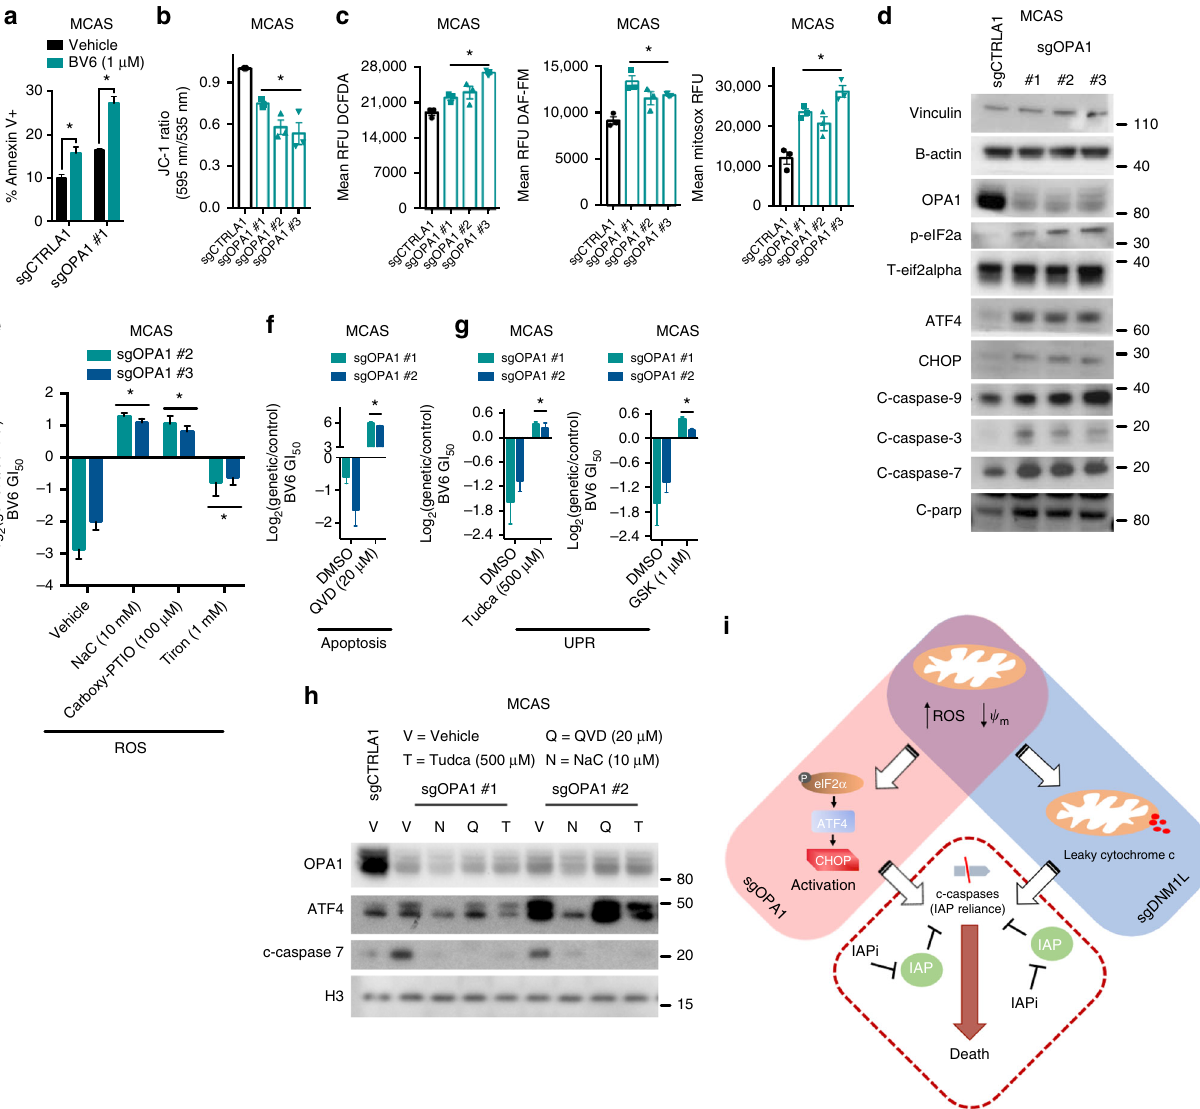
Fig. 5 OPA1 loss leads to induction of ER stress markers and changes in the levels of cleaved caspases. a Percentage of annexin V + MCAS cells transduced with a control targeting sgRNA or a sgRNAs targeting OPA1 ( n = 3). Data are mean ± SEM. * p < 0.05 by Student ’ s t -test. b Ratio of JC-1 fl uorescence (595 nm/535 nm) in MCAS cells transduced with control sgRNA or three independent sgRNAs for OPA1 ( n = 3). Data are mean ± SEM. * p < 0.05 by one-way ANOVA. c Left, DCFDA raw fl uorescence units minus no stain fl uorescence units in MCAS cells transduced with control sgRNA or three independent sgRNAs for OPA1 ( n = 3). Data are mean ± SEM. * p < 0.05 by one-way ANOVA. Middle, DAF-FM raw fl uorescence units minus no stain fl uorescence units in MCAS cells transduced with control sgRNA or three independent sgRNAs for OPA1 ( n = 3). Data are mean ± SEM. * p < 0.05 by one-way ANOVA. Right, mitosox raw fl uorescence units minus no stain fl uorescence units in MCAS cells transduced with control sgRNA or three independent sgRNAs for OPA1 ( n = 3). Data are mean ± SEM. * p < 0.05 by one-way ANOVA. d Immunoblot of indicated proteins from the UPR and apoptosis pathways in MCAS cells transduced with control sgRNA or three independent sgRNAs for OPA1 . Immunoblots are representative of three independent experiments. e Log 2 (sgOPA1/sgCTRLA1) BV6 GI 50 value in MCAS cells treated with either vehicle or one of the following: NaC (10 mM), Tiron (1 mM), and Carboxy- PTIO (100 μ M) ( n = 3). Data are mean ± SEM. * p < 0.05 by one-way ANOVA. f Log 2 (sgOPA1/sgCTRLA1) BV6 GI 50 value in MCAS cells treated with either vehicle or Q-VD-OPh (20 mM) ( n = 3). Data are mean ± SEM. * p < 0.05 by one-way ANOVA. g Log 2 (sgOPA1/sgCTRLA1) BV6 GI 50 value in MCAS cells treated with either vehicle or one of the following: Tudca (500 μ M) or GSK2606414 (1 μ M) ( n = 3). Data are mean ±SEM. * p < 0.05 by one-way ANOVA. h Immunoblot of indicated proteins in MCAS cells transduced with control sgRNA or two independent sgRNAs for OPA1 treated with vehicle, QVD, Tudca, or NaC at indicated doses. Immunoblots are representative of two independent experiments. i Model of SMAC mimetic sensitivity in OPA1 or DNM1L loss